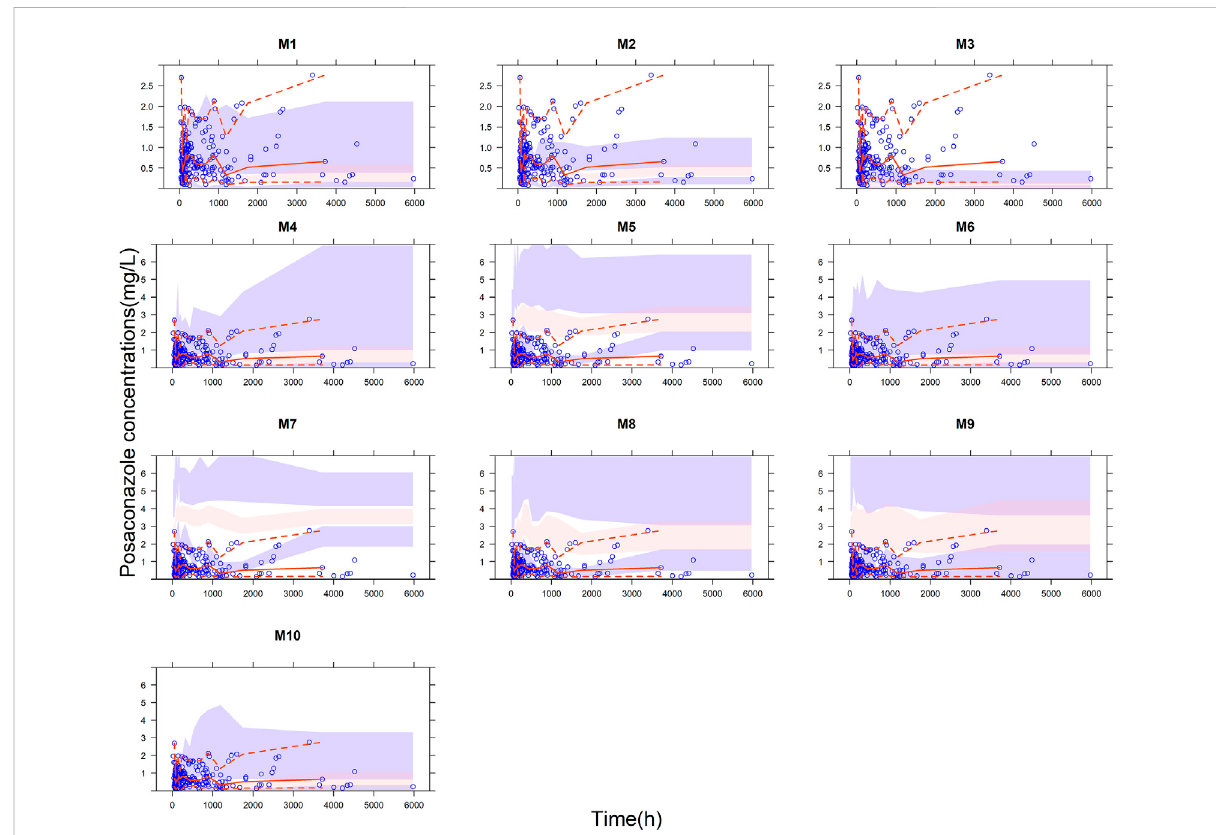
FIGURE 2 Visual predictive check (VPC) plots for the published model of posaconazole evaluated with the whole cohort. Blue points represent the observations,and red lines represent the5th, 50th and 95th percentiles of theobserved data.The color-shaded areasrepresent the95%con fi dence intervals around the simulated 5th, 50th, and 95th